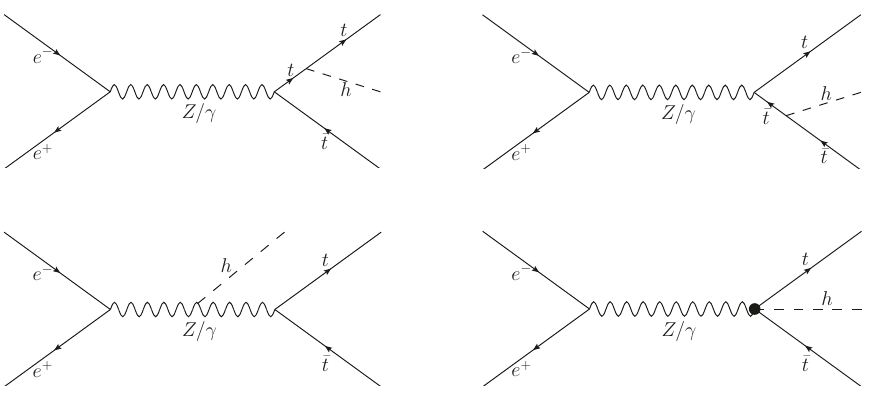
(cid:22) th process. In the SM, the dominant contri- Figure 4 . Leading-order diagrams for the e + e (cid:0) ! t bution are the ones involving the top Yukawa coupling. Other EFT contributions (including that of four-fermion operators, not depicted) should be well constrained by other